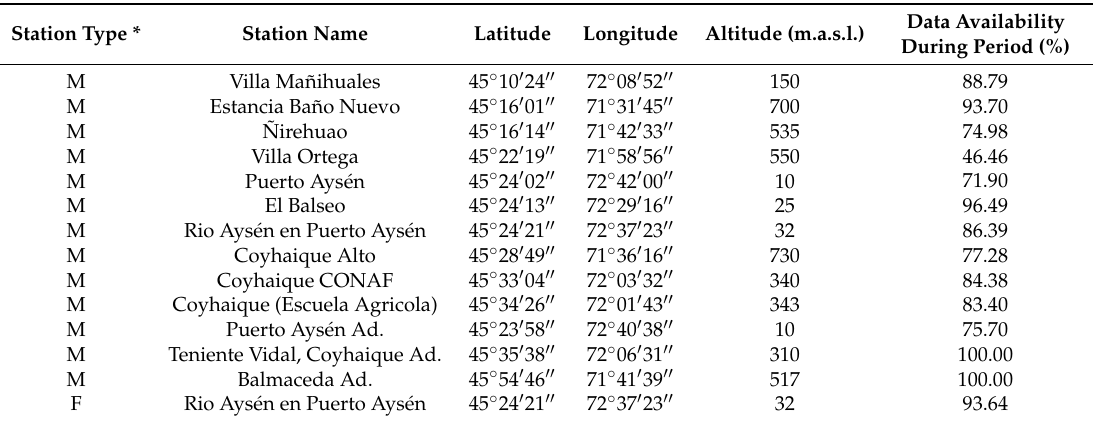
Table 1. Hydro-meteorological stations located in the Ays é n river